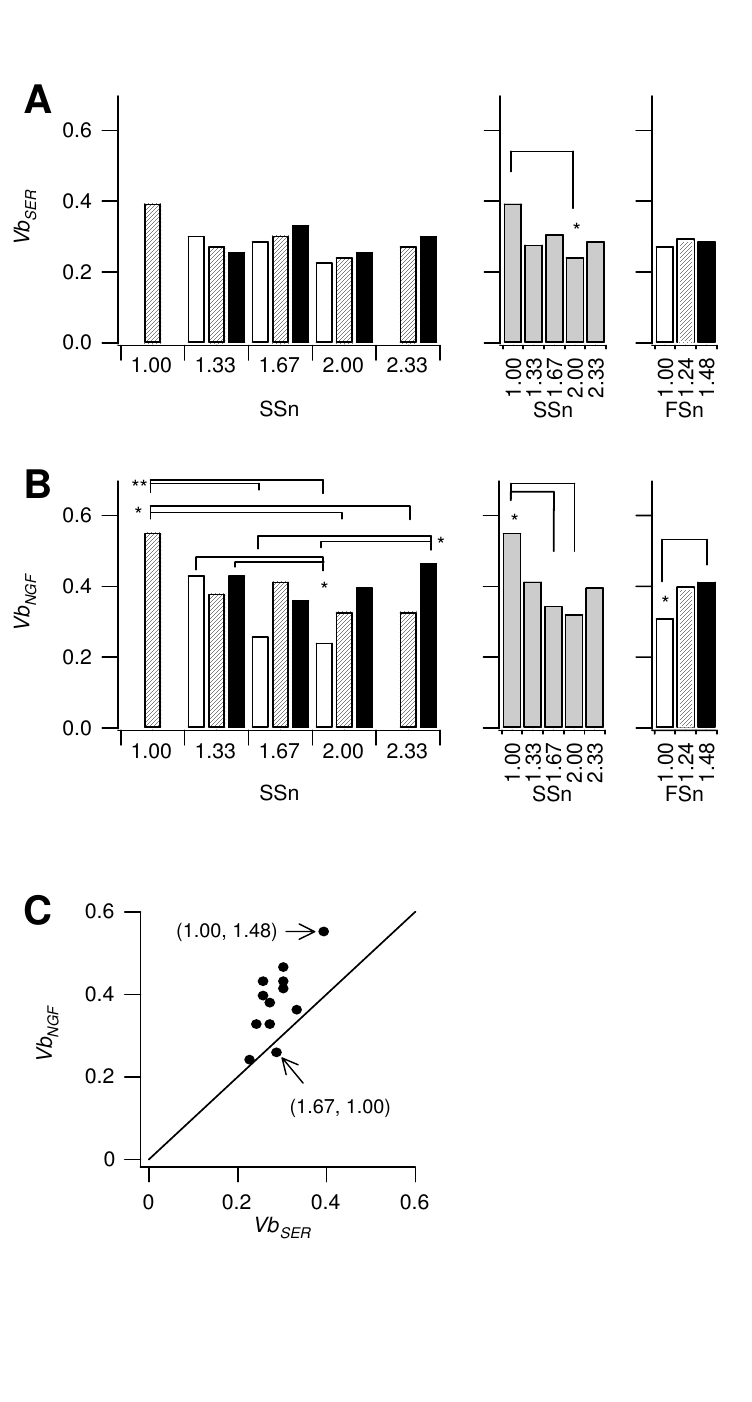
Figure 7 Viabilities of single-sorted cells plated in separate wells . Cell viability in each of the twelve sub-fractions with ( B ) and without ( A ) NGF. Left, average for each subfraction; middle, average for SSn ; right, average for FSn . Shading corresponds to that in Fig. 4C. Statistically significant at * P < 0.05; ** P < 0.005. C: SER versus NGF for each subfraction. The slope of the line